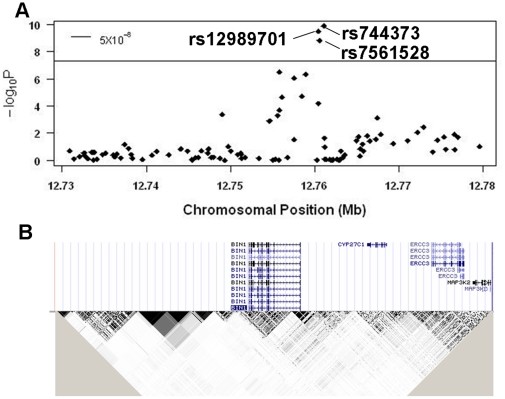
Multiple variants at the BIN1 locus are strongly associated with AD.A) Meta-analysis for all sample sets (including Pfizer, ADNI, GenADA, Harold and QFP) at the chr2 region (500 kb upstream and downstream of BIN1). SNPs rs744373, rs12989701 and rs7561528 are all strongly associated with disease status below the genome-wide significance level. B) Pairwise LD structure (r2) calculated in Haploview using HapMap genotype data (phase III) in 60 unrelated CEPH samples (gene structures were shown using the UCSC genome browser for the hg18 assembly). While rs744373 and rs7561528 are in strong LD, limited LD exists between rs12989701 and rs744373 (r2 = 0.01 in HapMap samples and r2 = 0.05 in Pfizer data set).